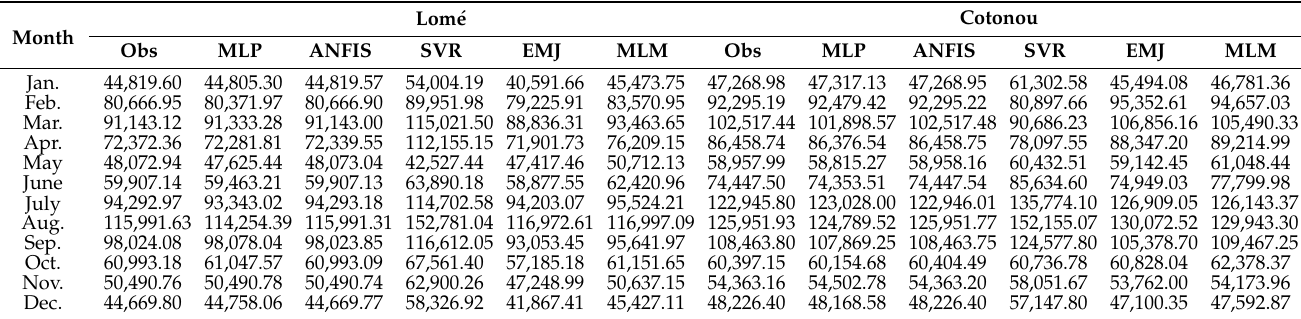
Table 13. Wind turbine output energy estimation (kWh).